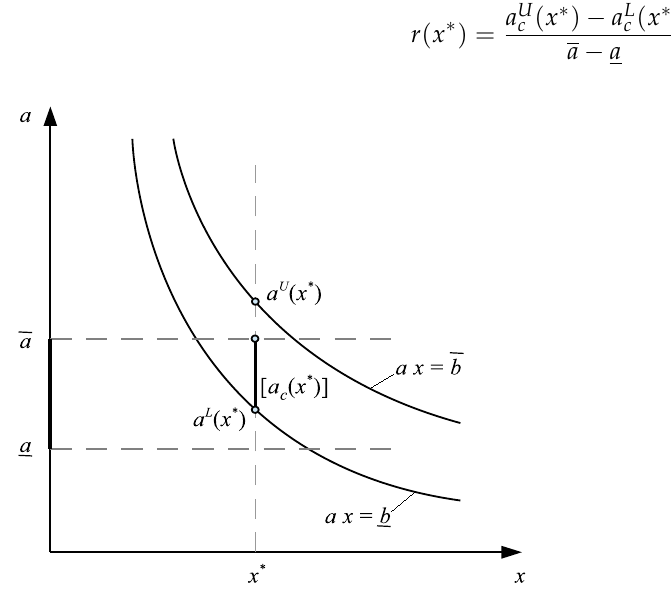
Figure 5. Illustration of the computation method of r ( x ∗ )